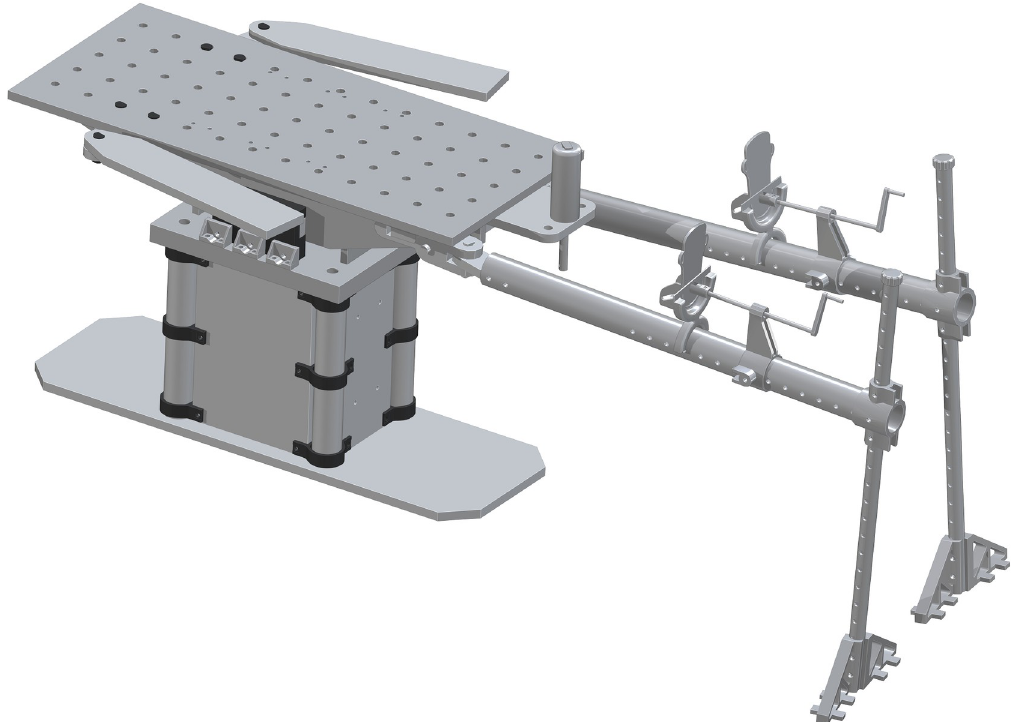
Fig 27. Final Table Assembly without cover and